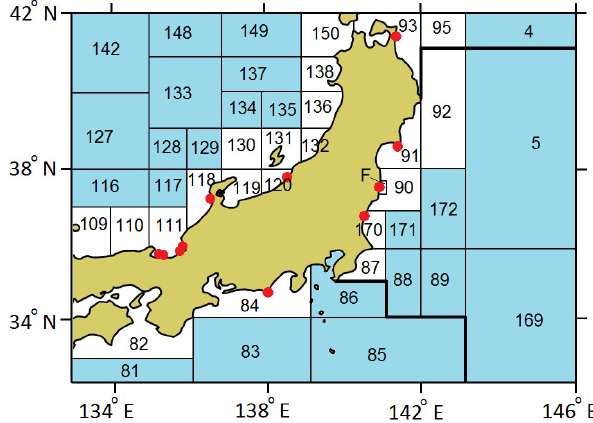
Figure 2. The box system for the area close to Fukushima Dai- ichi Nuclear Power Plant (FDNPP). The shaded boxes represent the deep-sea water boxes divided on three vertical layers. The NPPs are shown by filled circles. Coastal box around the FDNPP (marked by “F”) is inside box 90. A thick line delimits the area of the Fukushima accident